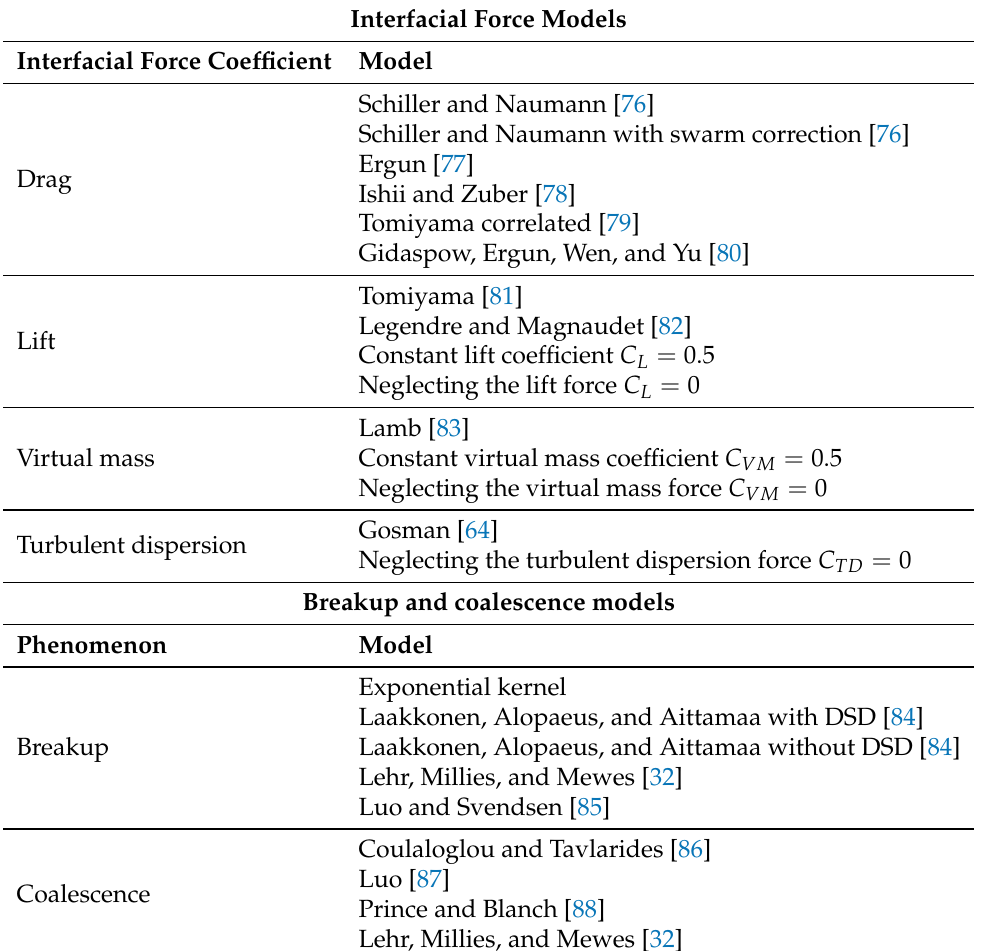
Table 2. Examined interfacial force, breakup and coalescence